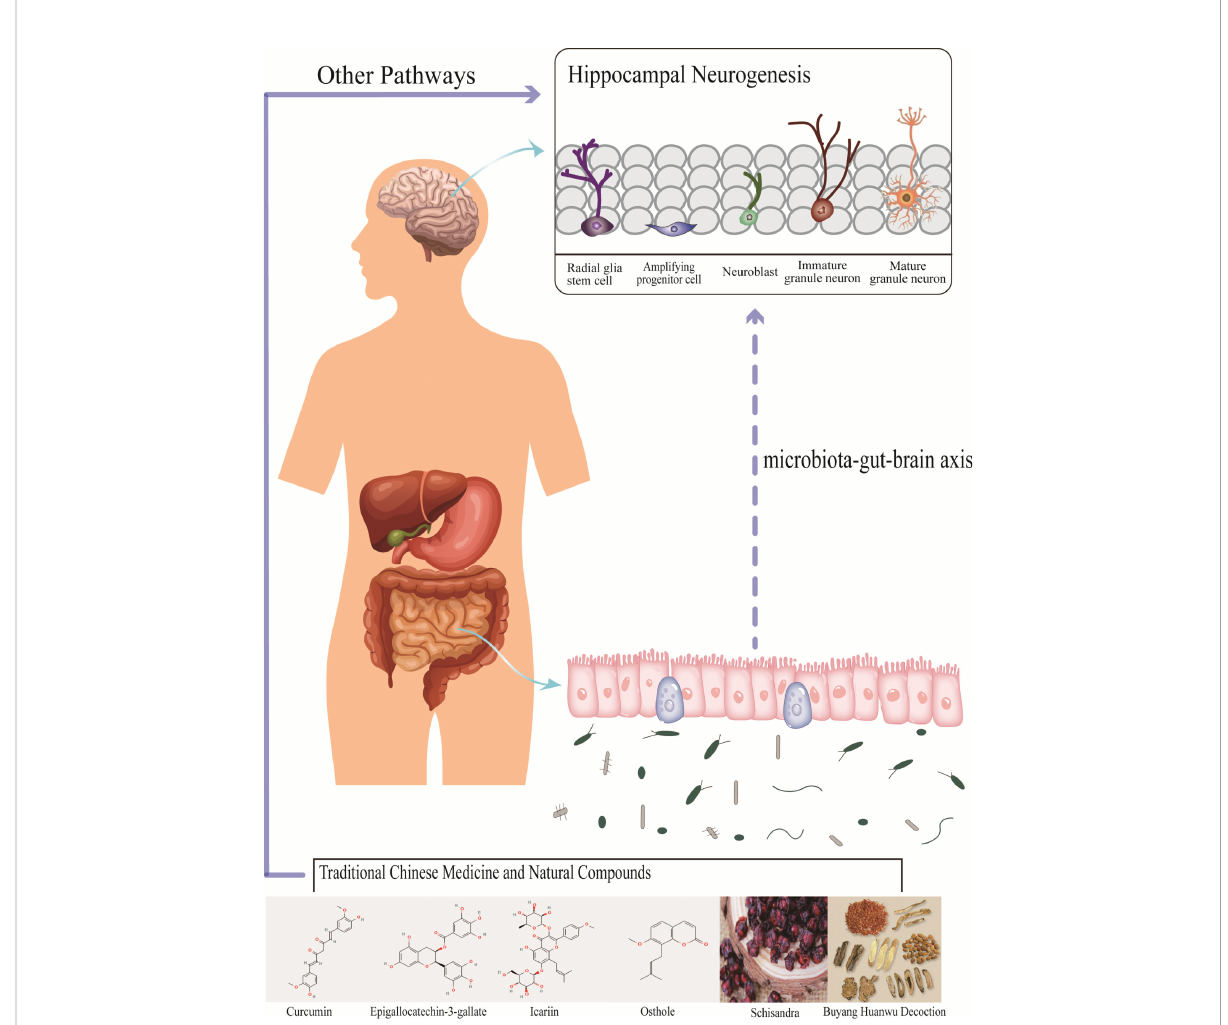
FIGURE 5 Traditional Chinese medicine and natural compounds affect the abundance of gut microbiota, and change the niche of neural stem cells through the three major pathways of microbiota-gut-brain axis, which may affect neurogenesis. However, there is little evidence that most Traditional Chinese medicine and natural compounds change neurogenesis through this